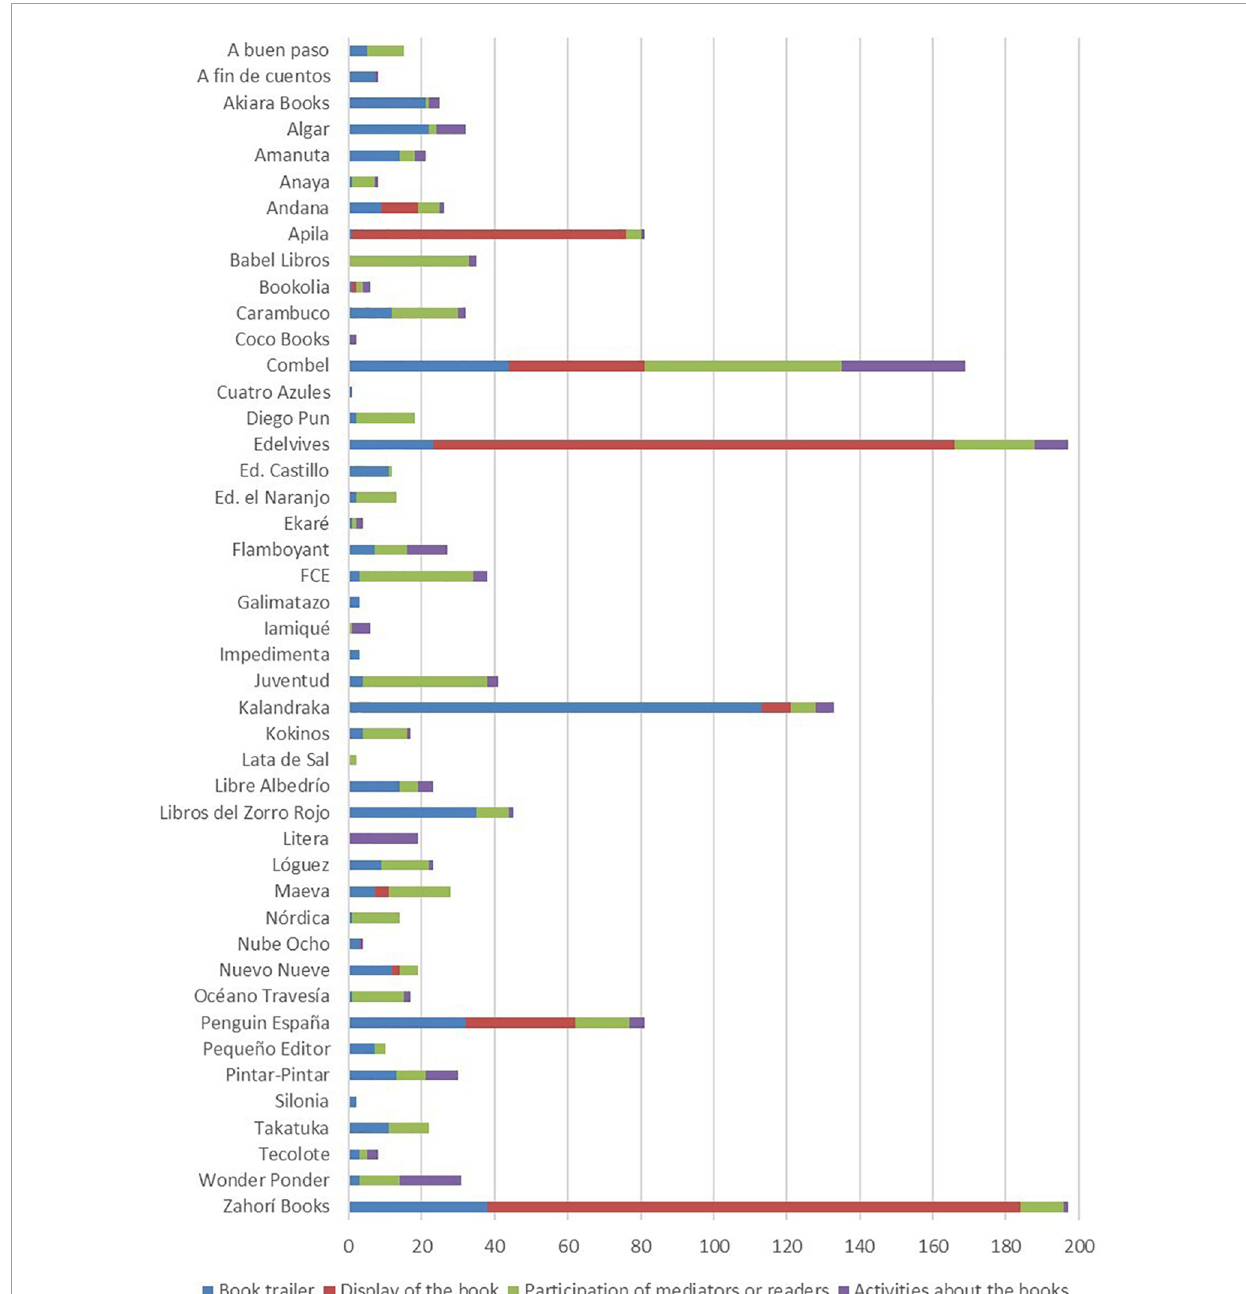
FIGURE2 Type of videos for the promotion of children’s picturebooks selected, by publisher.